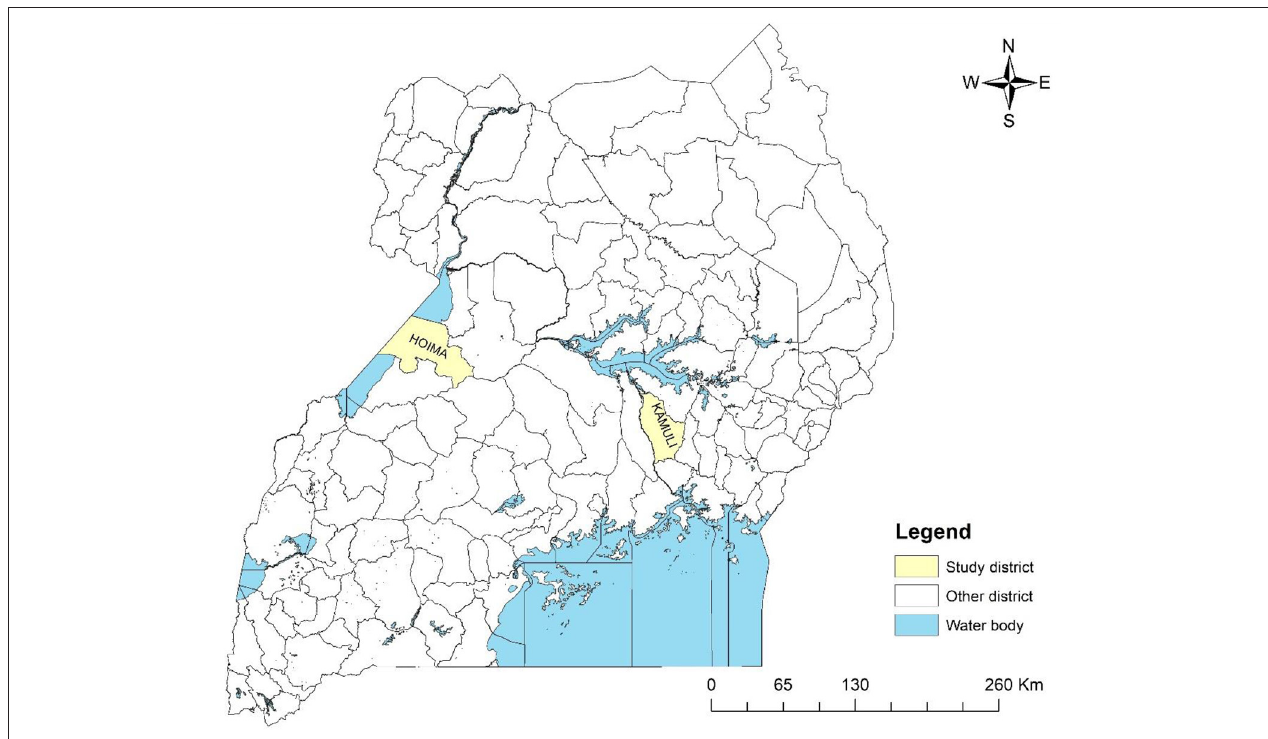
FIGURE 1 | Map of Uganda showing the study districts (shaded in